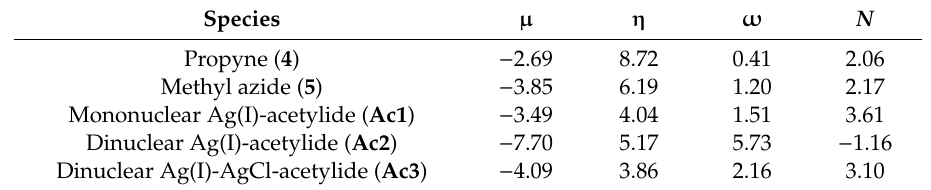
Table2. Globalreactivityindices,namely, µ , η , ω and N